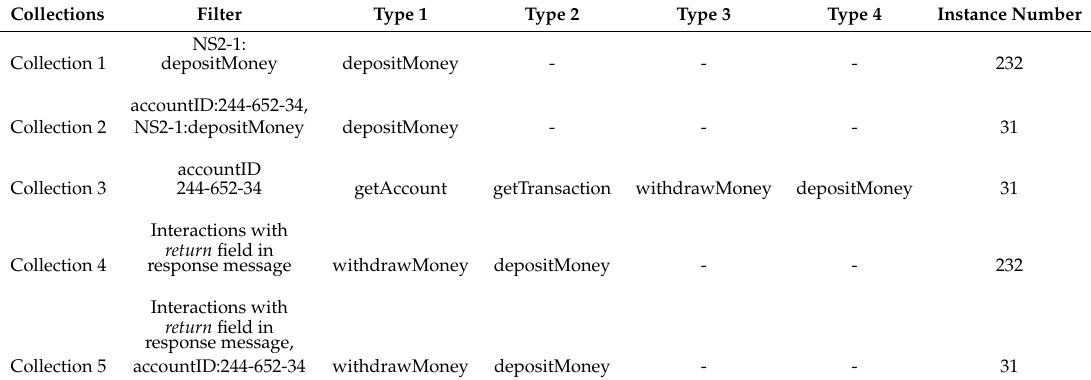
Table 1. Evidence collection result for the banking data